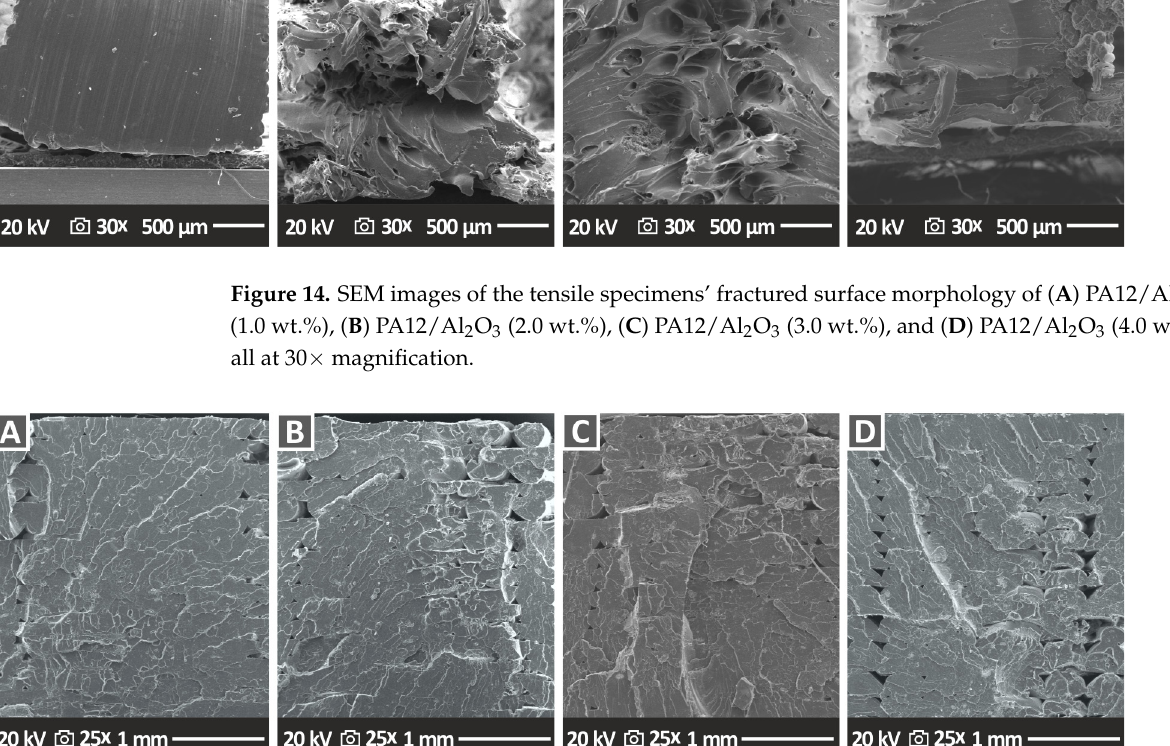
Figure 15. SEM images of the tensile specimens’ fractured surface morphology of ( A ) PLA/Al 2 O 3 (1.0 wt.%), ( B ) PLA/Al 2 O 3 (2.0 wt.%), ( C ) PLA/Al 2 O 3 (3.0 wt.%), and ( D ) PLA/Al 2 O 3 (4.0 wt.%), all at 25× magnification.